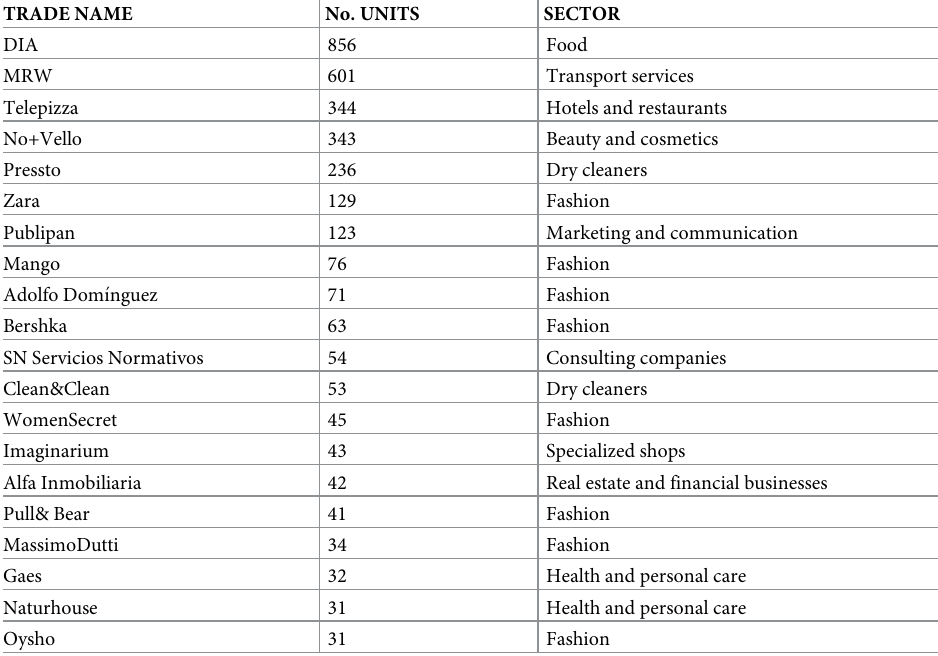
Table 1. The first 20 Spanish trade names present in Latin America. TRADE